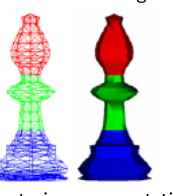
Figure 2. K-means clustering segmentation of points cloud (Source: Sun et al., 2006)